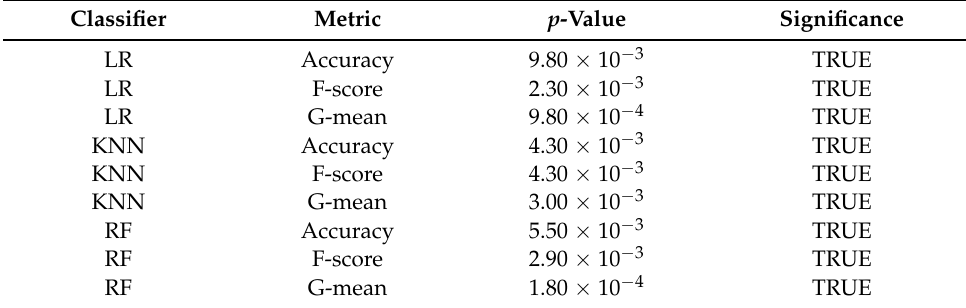
Table 4. Results for Friedman test. Statistical significance is tested at a level of α = 0.05. The null hypothesis is that there is no difference in the classification outcome across